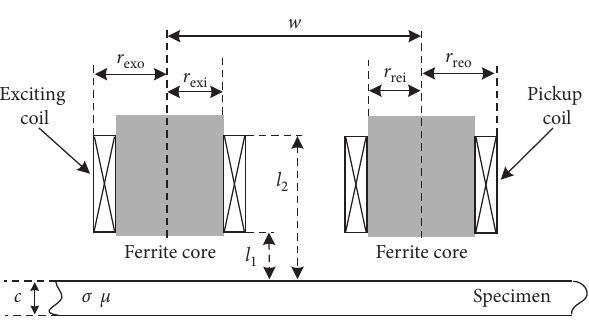
Figure 5: Structure of the TR probe. Table 1: TR probe